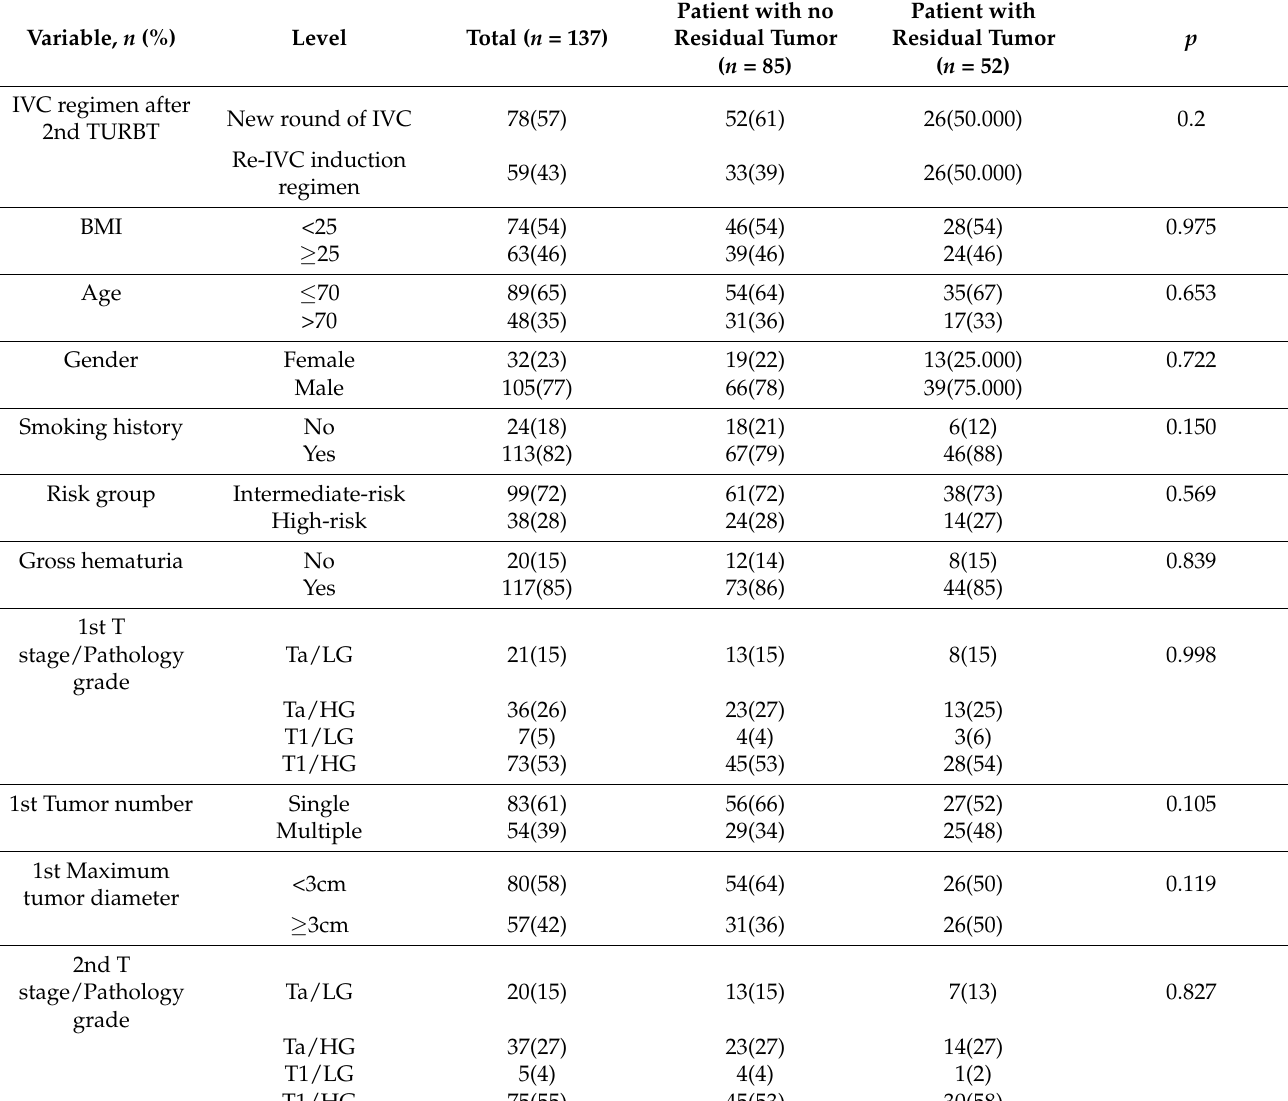
Table 1. Patient